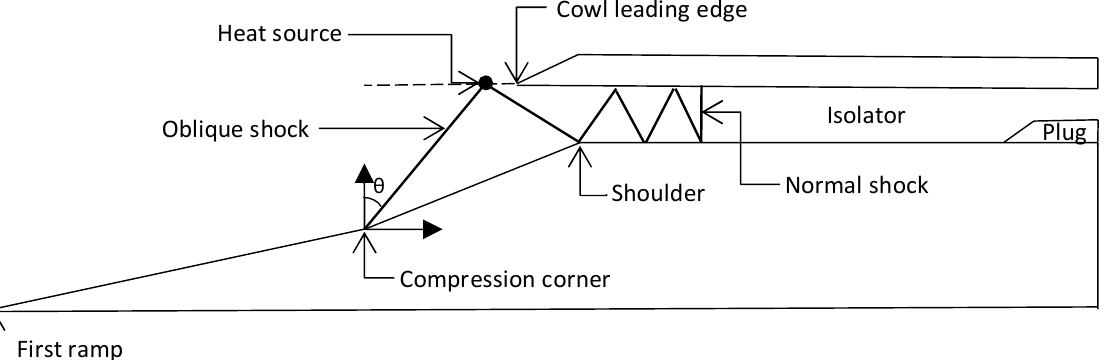
Figure 3. Location of the heat source effects.